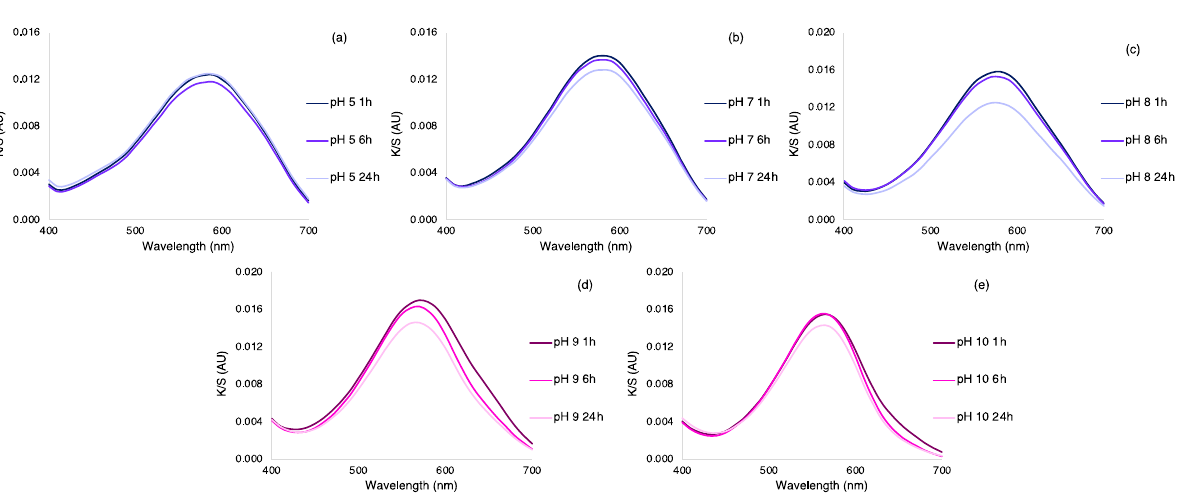
Table 7. K/S, ∆ E, and UPF values of the dyed silk samples with di ff erent concentrations of AzoIz.Pip under pH 6 and 40 °C and immersed in a Bri tt on–Robinson solution at pH 10. [AzoIz.Pip]